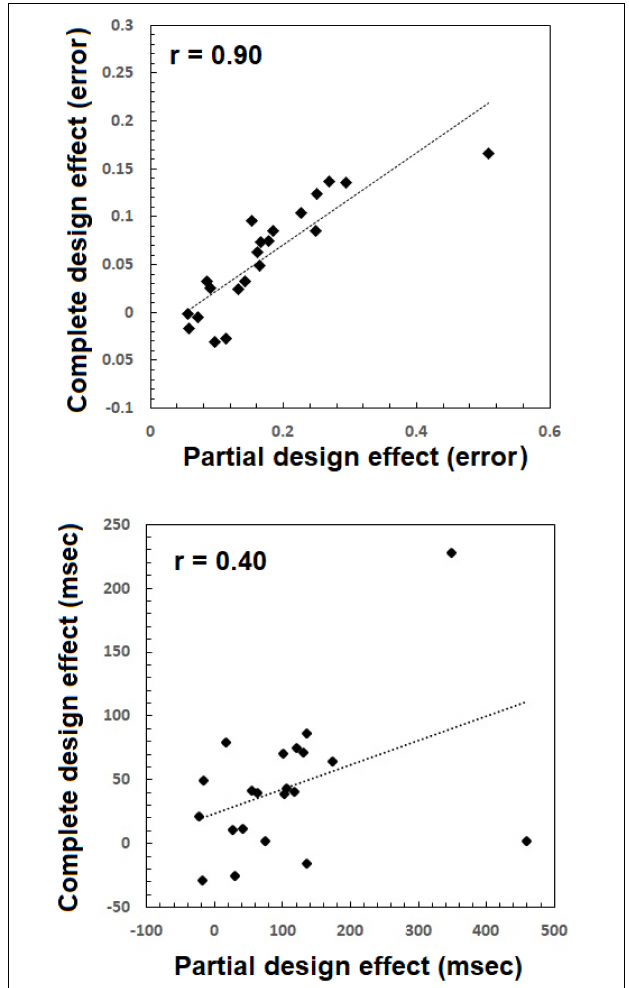
FIGURE 10 | Composite face effects for each participant based on the partial design (abscissa) and the complete design (vertical axis) plotted one against the other, for error rate (top) and mean RTs (bottom)